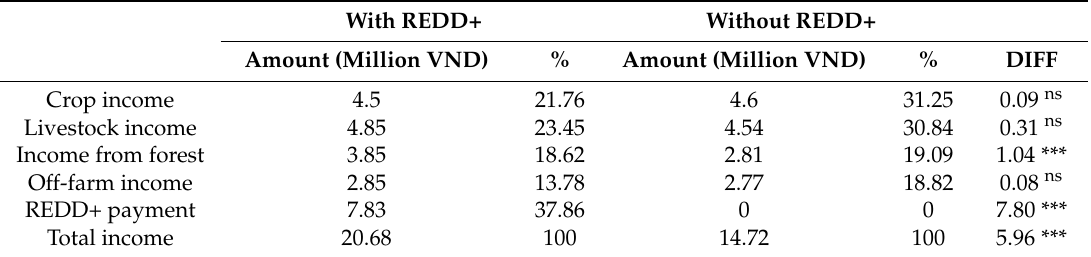
Table 9. Contribution of REDD+ to household income, Con Cuong District, Nghe An Province, 2016. With